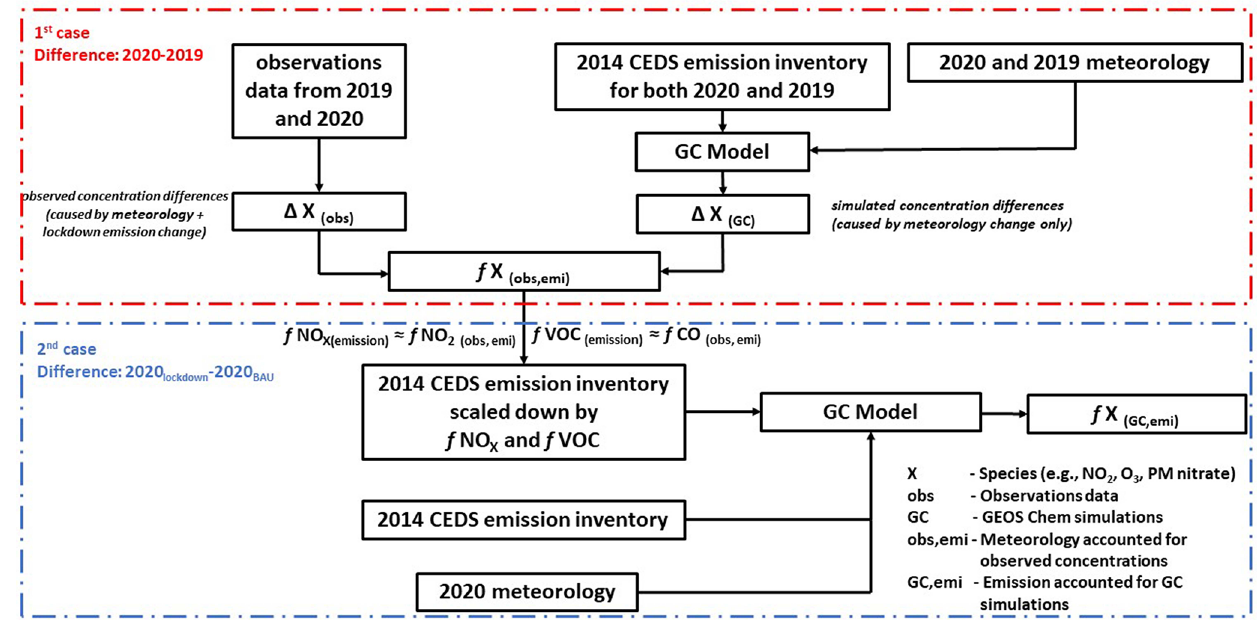
Figure 1. Schematic diagram of our methodology for calculating the observed pollutant concentration changes with meteorology accounted for between 2020 and 2019 and GC pollutant concentration changes with emissions accounted for between 2020 lockdown and 2020 BAU scenarios.